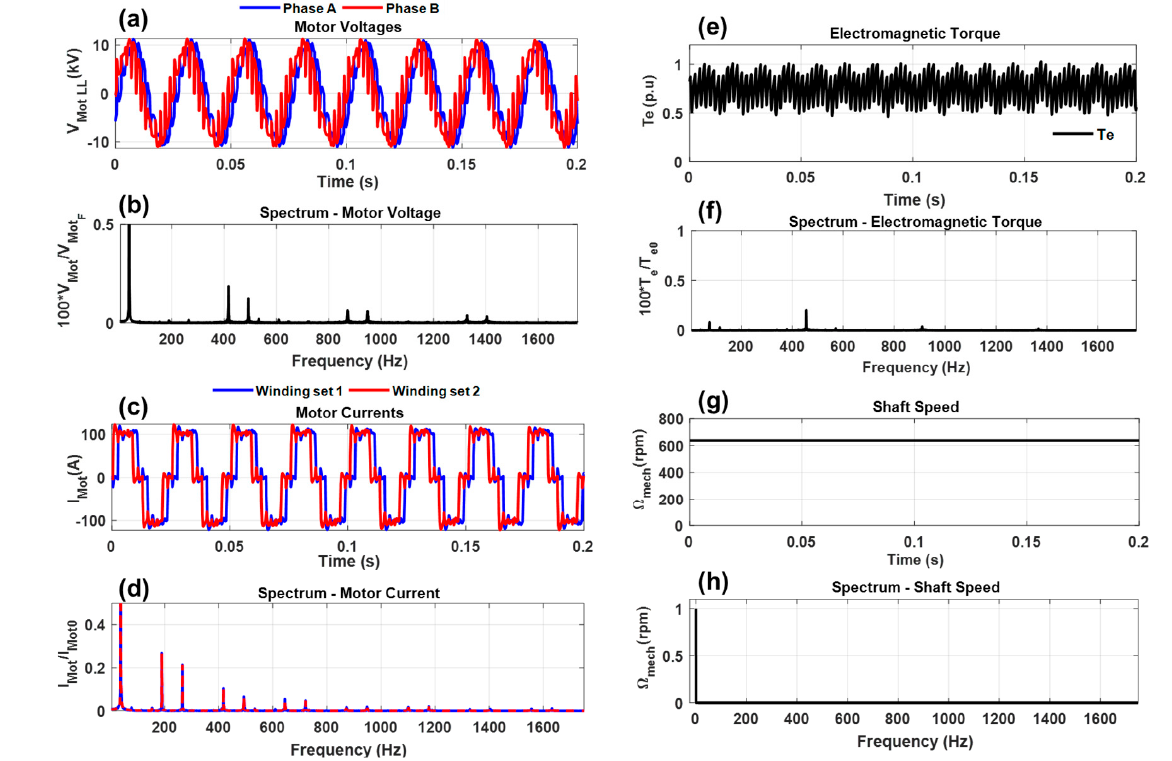
Figure 21. Sample simulation results of a 12/12-pulse LCI system at 40 Hz: ( a ) motor voltages, ( b ) spectrum of motor voltage, ( c ) motor currents, ( d ) spectrum of motor current, ( e ) motor electromagnetic torque, ( f ) spectrum of motor electromagnetic torque, ( g ) shaft speed and ( h ) spectrum of shaft speed.